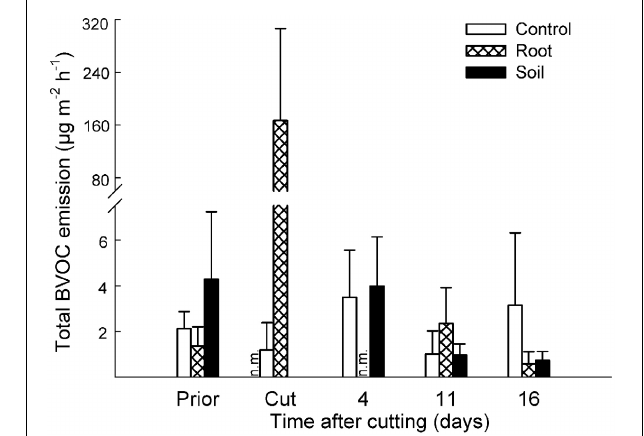
FIGURE 2 | Effect of experimental manipulations on biogenic volatile organic compound (BVOC) emissions from mixed heath mesocosms. The total emissions of (A) sesquiterpenes and (B) other BVOCs (mean + SE, n = 3) with intact vegetation (control), cut abovegroundvegetation (root mesocosms), and all vegetation removed (soil mesocosms) prior to cutting (Prior), directly after cutting (Cut) and after cutting at different time intervals. n.m., not measured.